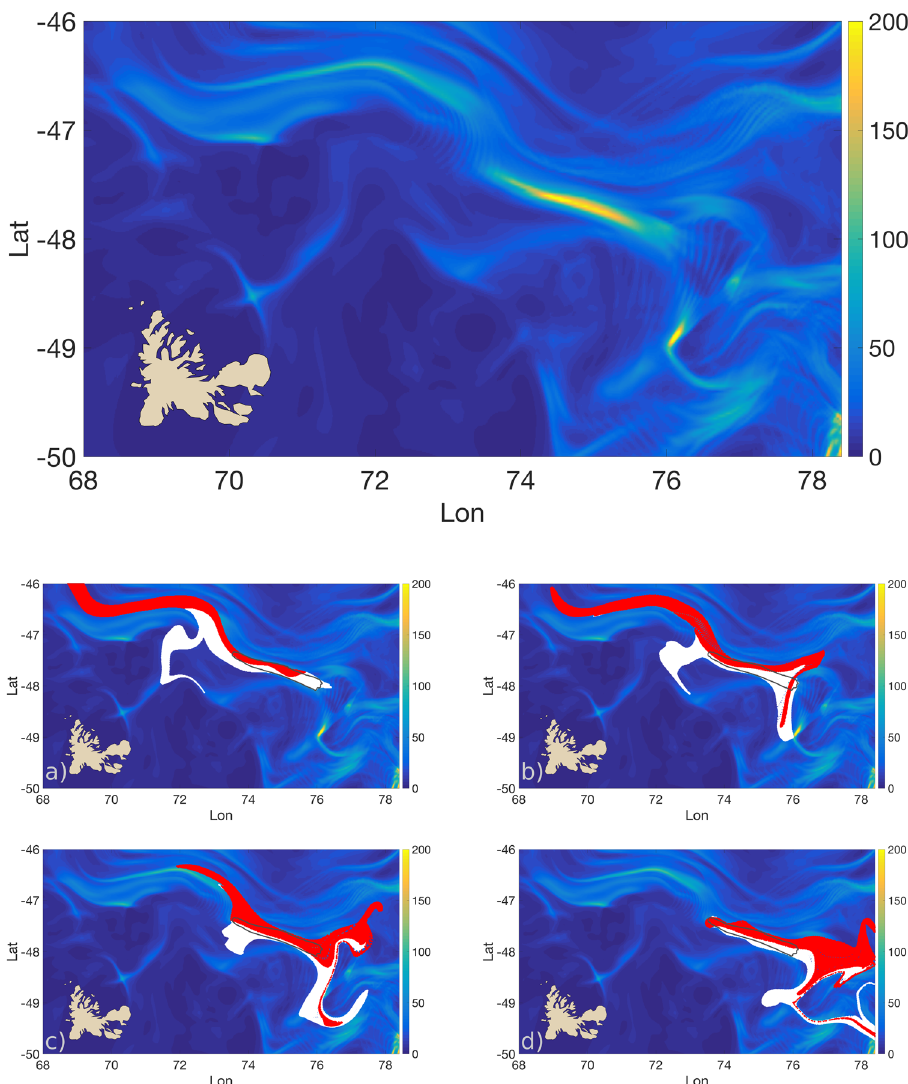
Fig. 7 Lagrangian betwenness in the Kerguelen region. On the top: B L fi eld from altimetry data in the region north-east of the Kerguelen Islands for the 1st of December 2007 with integration time τ = 20. A marked high-betweenness strip is located in the area where the Polar Front meets the Antarctic Circumpolar Current. On the bottom, a – d Evolution of the Circumpolar Current patch (red) and the Polar Front patch (white) fl owing across the high- betweenness strip (delimited by the solid gray contour) at different intermediate times (1st, 7th, 14th, and 20th of December) from altimetry data. Waters from different current systems are funneled through the 20 km wide strip being partially mixed; they separate and disperse shortly after leaving this high- betweeness strip (see also the Supplementary Video 2 for the full